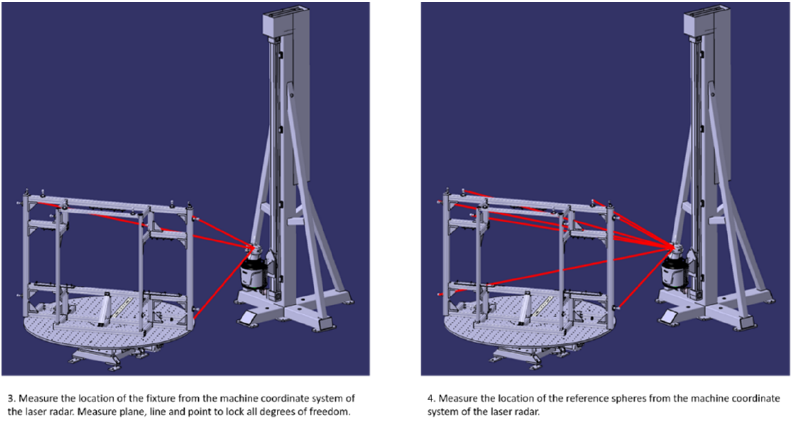
Figure 24. Description of system calibration procedure and update of the digital twin. Third and fourth working steps moving from the left illustration to the right illustration).